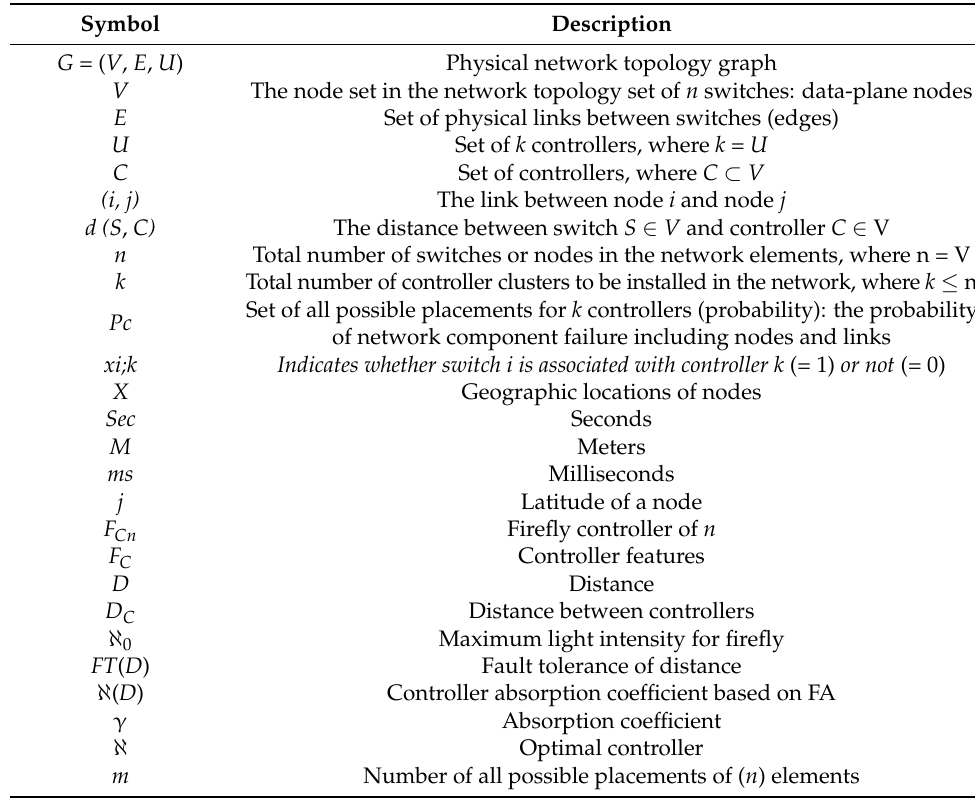
Table 3. Description of graph theory, topology, and other mathematical symbols.